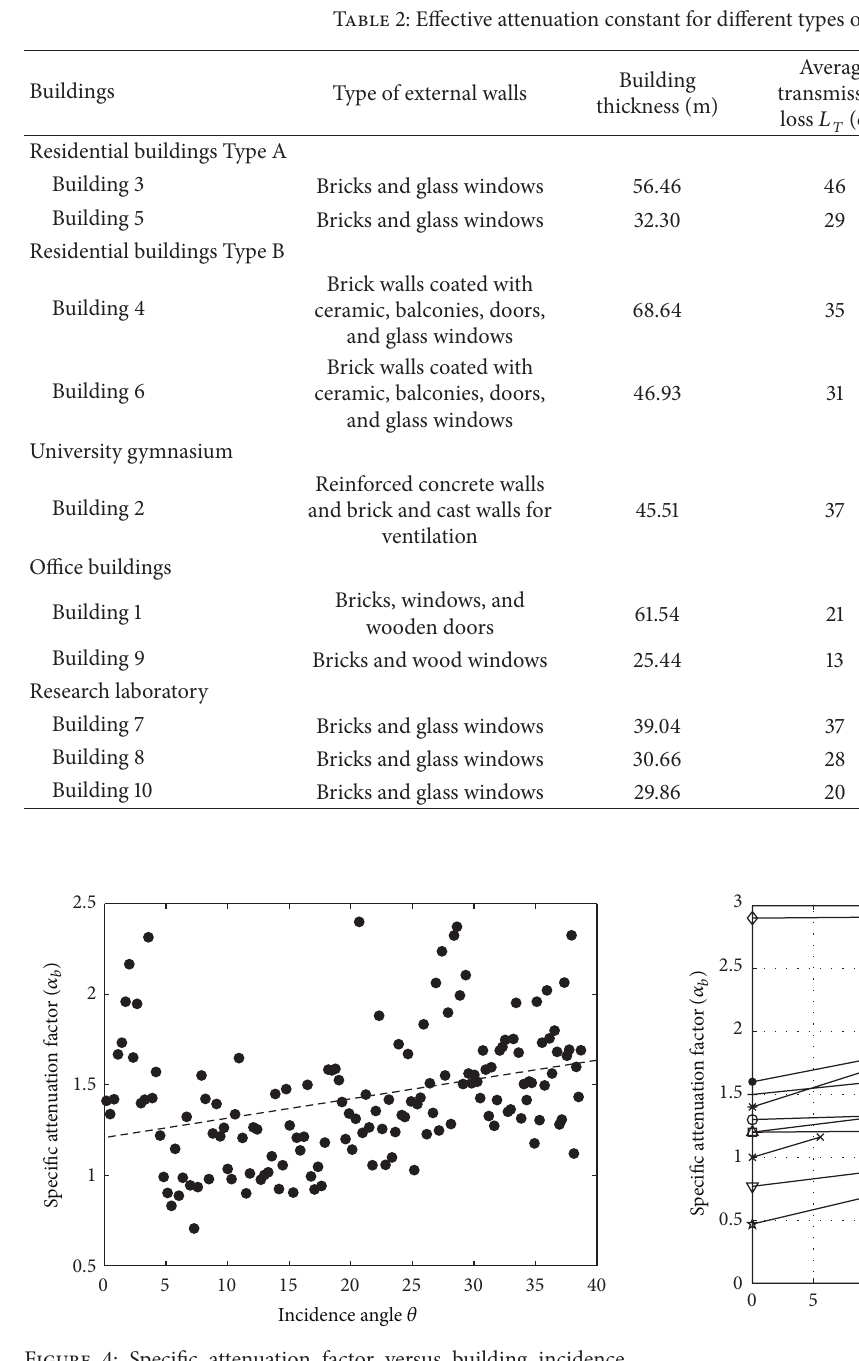
Figure 4: Specific attenuation factor versus building incidence angle, building 10.